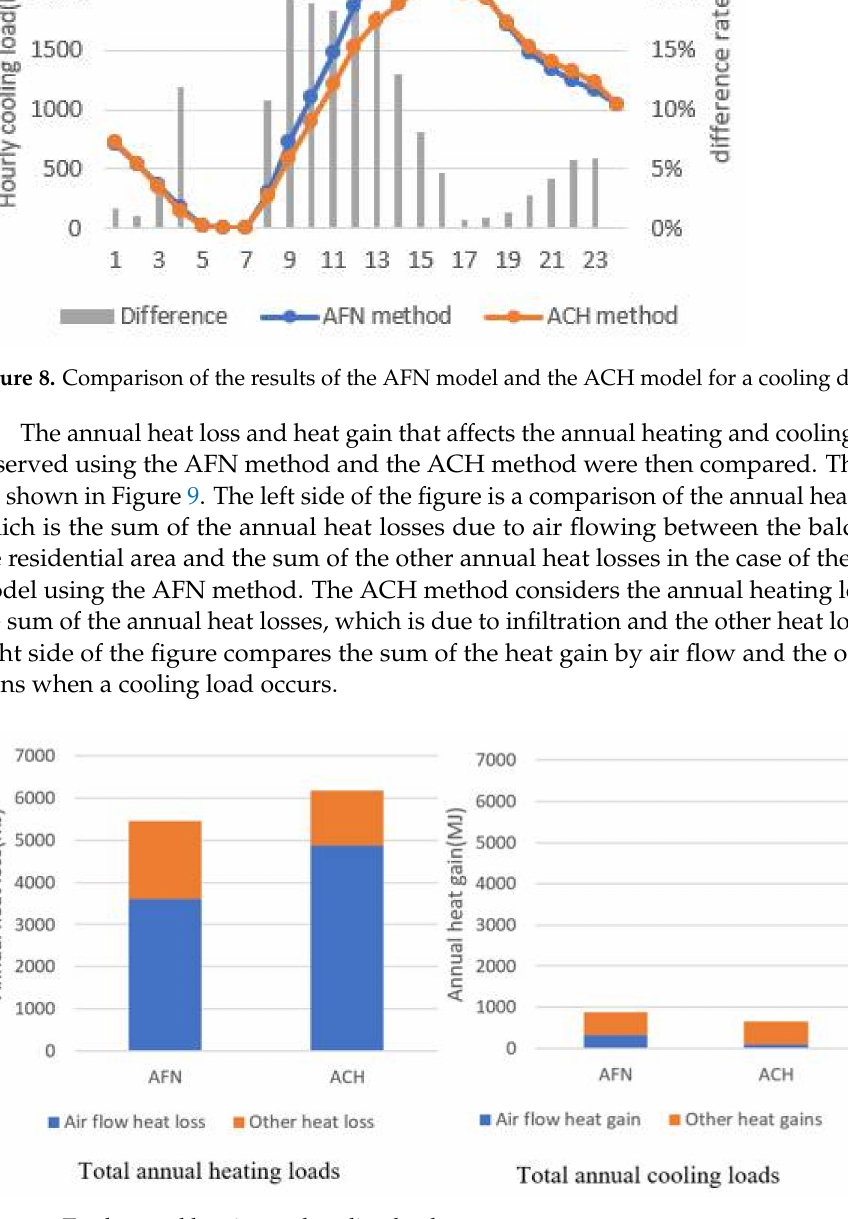
Figure 9. Total annual heating and cooling